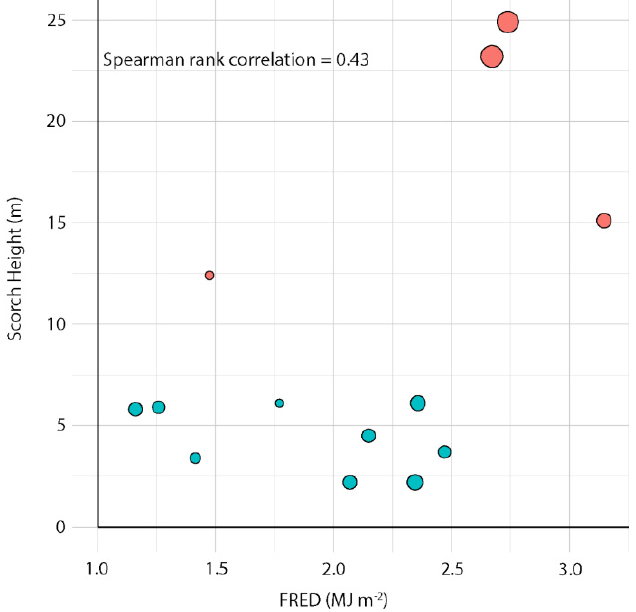
Figure 5. Mean fire radiative energy density (FRED) within 4 m radius circles around field scorch height measurements ( n = 13). Only measurements with complete fire front combustion profiles are shown, and post-frontal combustion is not included in any of the FRED estimates. Point size is scaled by the number of data points underneath the scorch height measurement (594–41,868 points) as a proxy for the amount of biomass available for energy absorption. Points shown as red have significant local Moran’s I spatial autocorrelation ( p < 0.1).